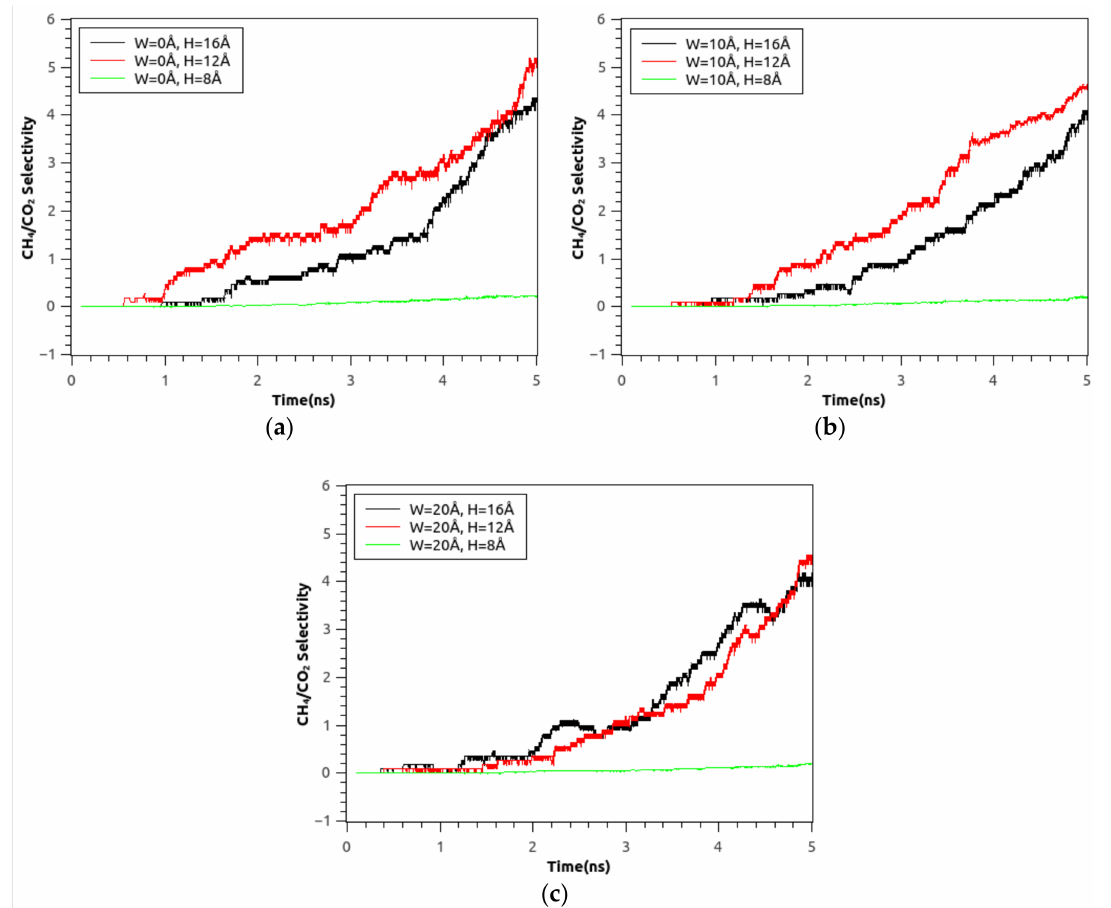
Figure 7. The effect of pore offset distance on the instantaneous CH 4 /CO 2 selectivity as a function of simulation time ( a ) W = 0 Å ( b ) W = 10 Å ( c ) W = 20 Å.